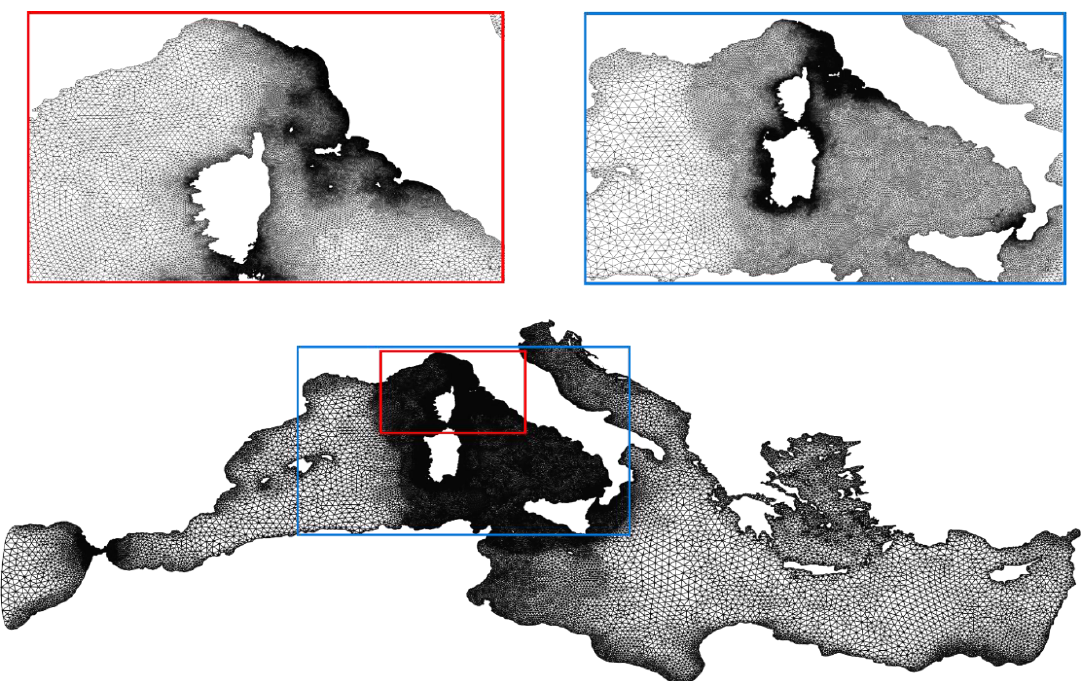
Figure 3. Extent of the WaveWatch III (WW3) domain with enlarged views of North-Western Mediterranean Sea (light blue box) and Tuscany Archipelago and Eastern Ligurian Coast (red box).